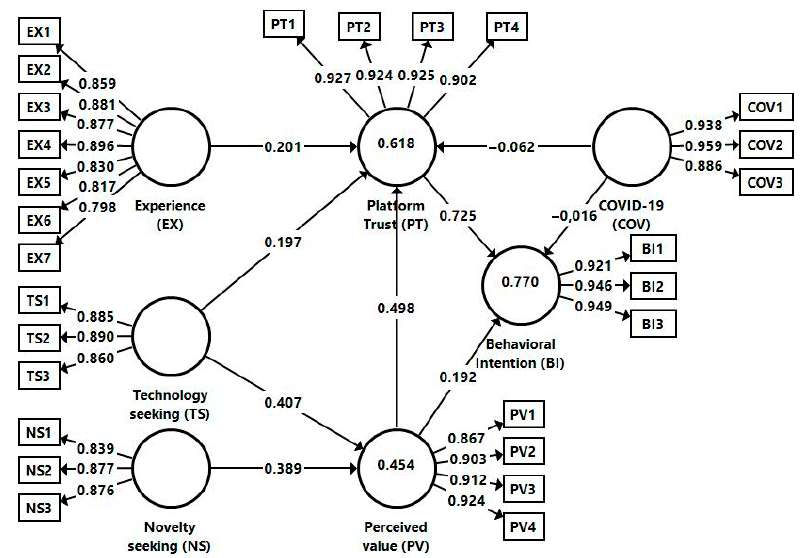
Figure 2. Structural model . Source: own calculations in SmartPLS.